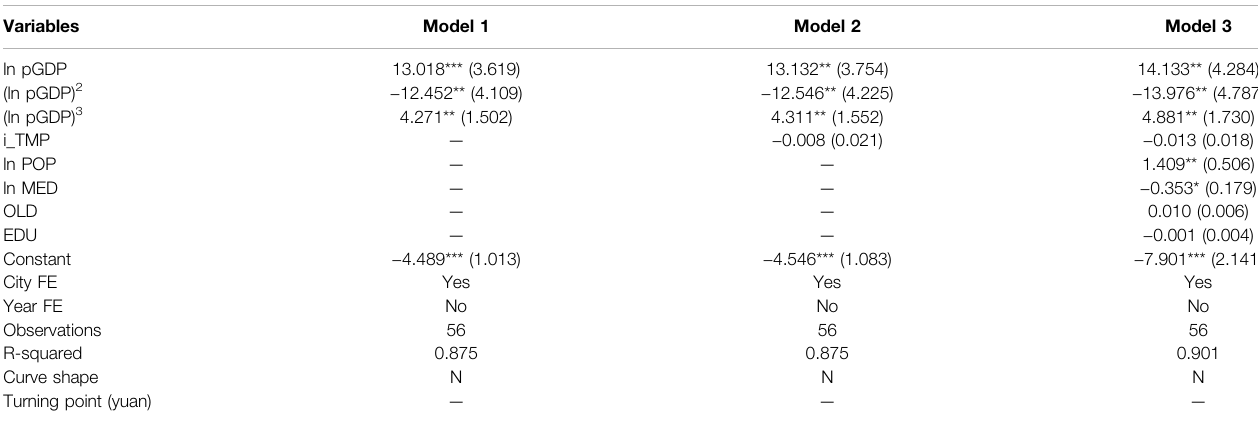
TABLE 5 | Regression results of the EKC models of